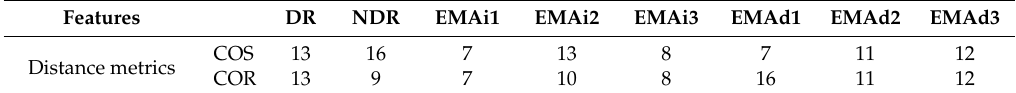
Table 8. Optimal numbers of different features after selection for Dataset II.